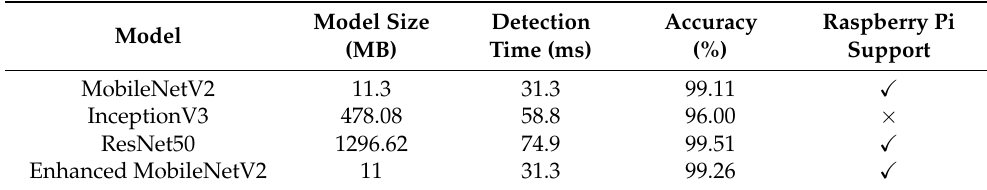
Table 3. Comparison of model sizes and detection times.